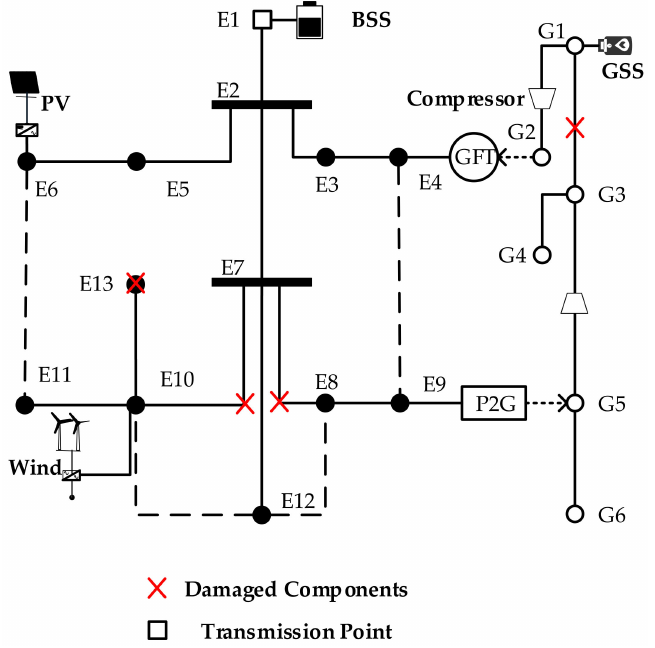
Figure 9. Modified 13-6-node